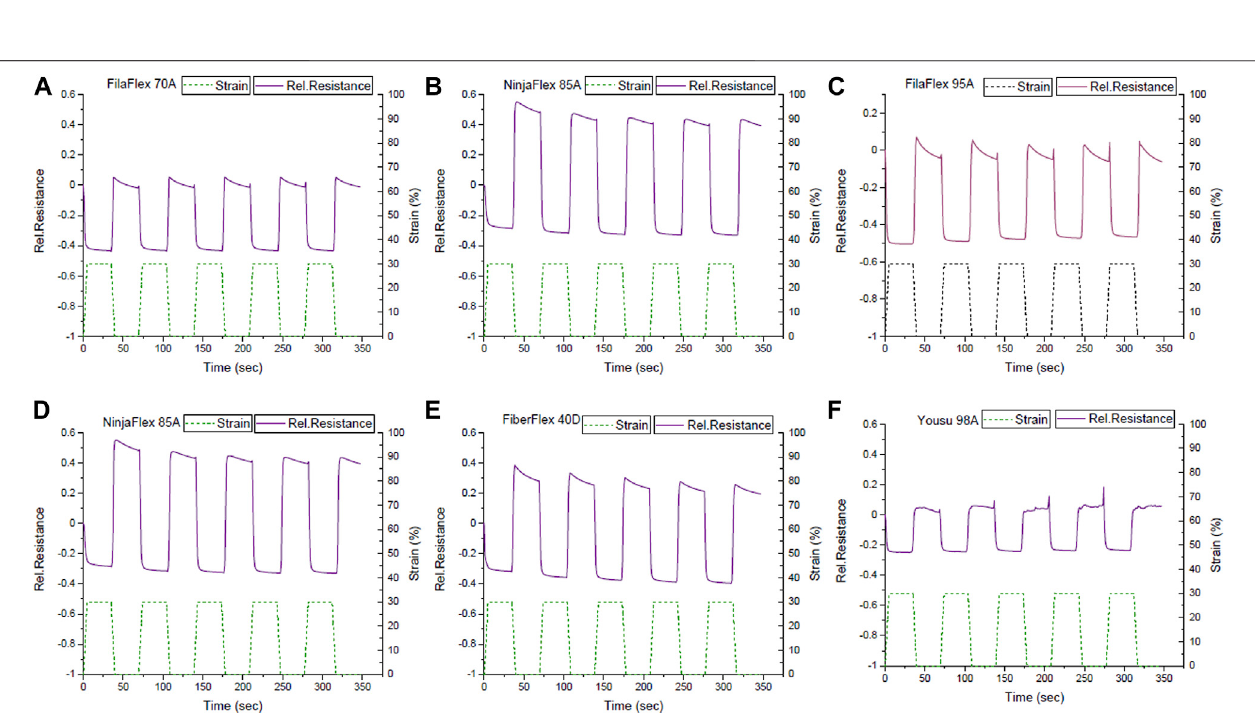
FIGURE7| Signalresponseduringthedynamictensiletestbetweenthestrains0and30%withadwelltimeof30 sat0%and30 sat30%strainfortheTPUstrips with integrated in situ sensing elements with a substrate; (A) FilaFlex 70A, (B) FilaFlex 82A, (C) FilaFlex 95A, (D) NinjaFlex 85A, (E) FiberFlex 40D, and (F) Yousu 98A.